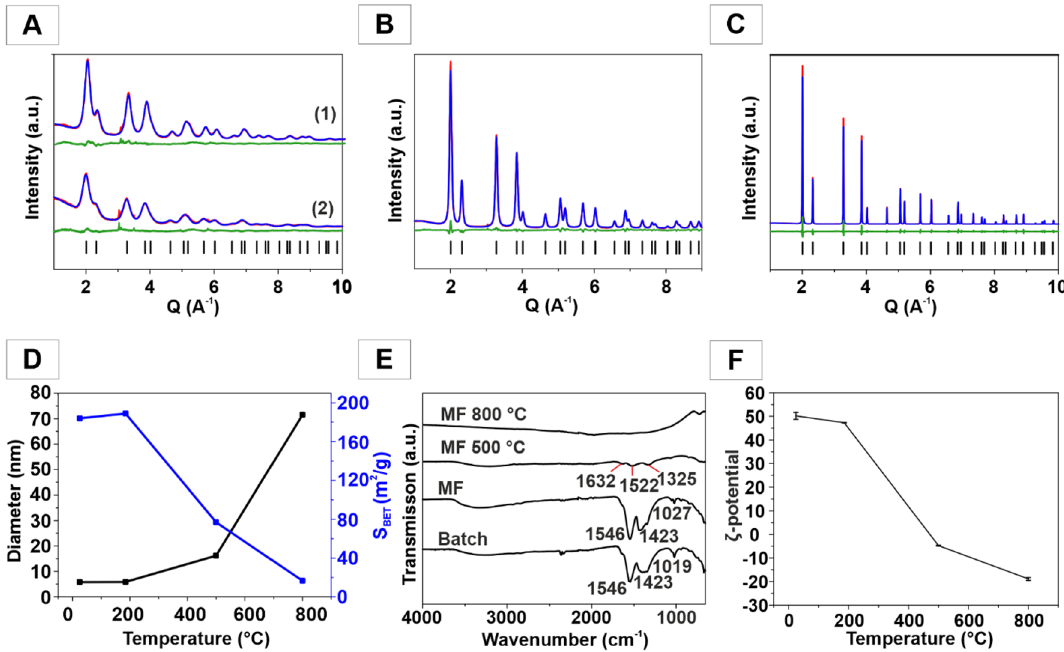
Figure 3. X-ray powder diffraction patterns with Rietveld refinements of CeO 2 NPs obtained by batch synthesis ( A1 ) and under segmented flow conditions ( A2 ) after annealing for 5 h at 185 °C. ( B ) CeO 2 annealed for 5 h at 500 °C and ( C ) 800 °C. Experimental data, Rietveld refinement and difference curve are shown as red, blue and green lines. Ticks indicate calculated positions of the Bragg intensities. ( D ) Average diameter and surface area as a function of annealing temperature. ( E ) FT-IR spectra of as-synthesized CeO 2 NPs for different annealing temperatures and ( F ) ζ-potential as a function of annealing